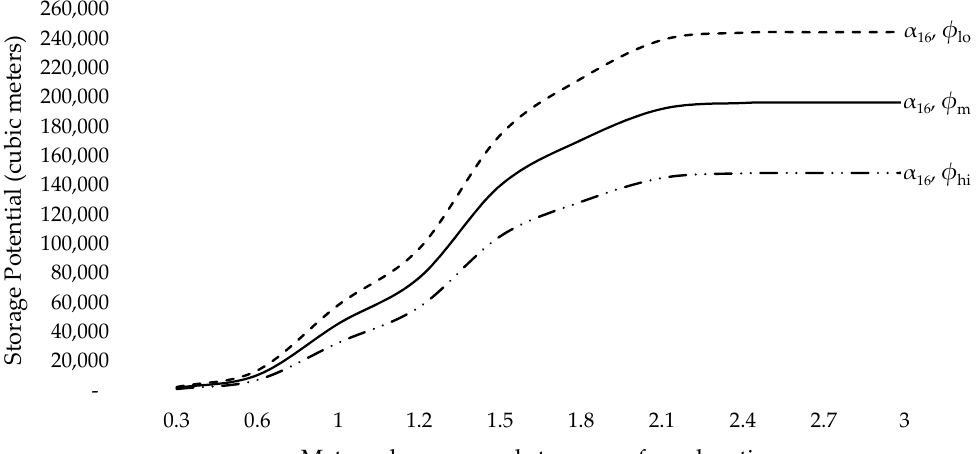
Figure 8. Graphed storage potentials simulated for a porosity value ( α ) of 16% ( α 16 ) and using observed highest ( φ hi ), middle ( φ m ), and lowest ( φ lo ) static groundwater levels measured at GWAAMON well 147334 over the last 21 years. Storage potentials increase as static groundwater table elevations ( φ ) decrease. The difference between the highest and lowest estimated storage potentials for an entirely inundated study site in this scenario (i.e., when φ hi , φ lo , and φ m are considered) is 96,100 m 3 (78 AF).